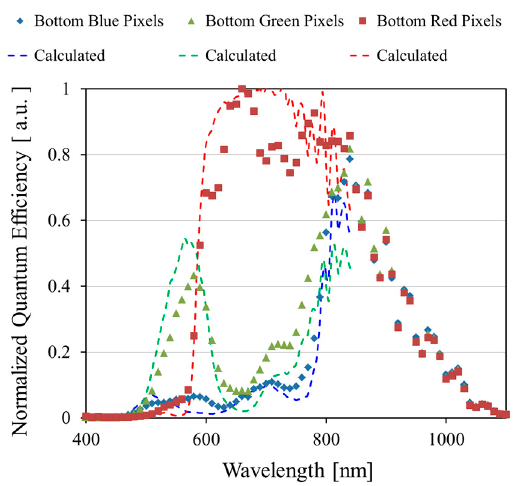
Figure 4. Measured and calculated normalized quantum efficiency of bottom PD array. NIR signals are detected by the bottom PD array, which comprises three types of pixels corresponding to the color filters on the top substrate.